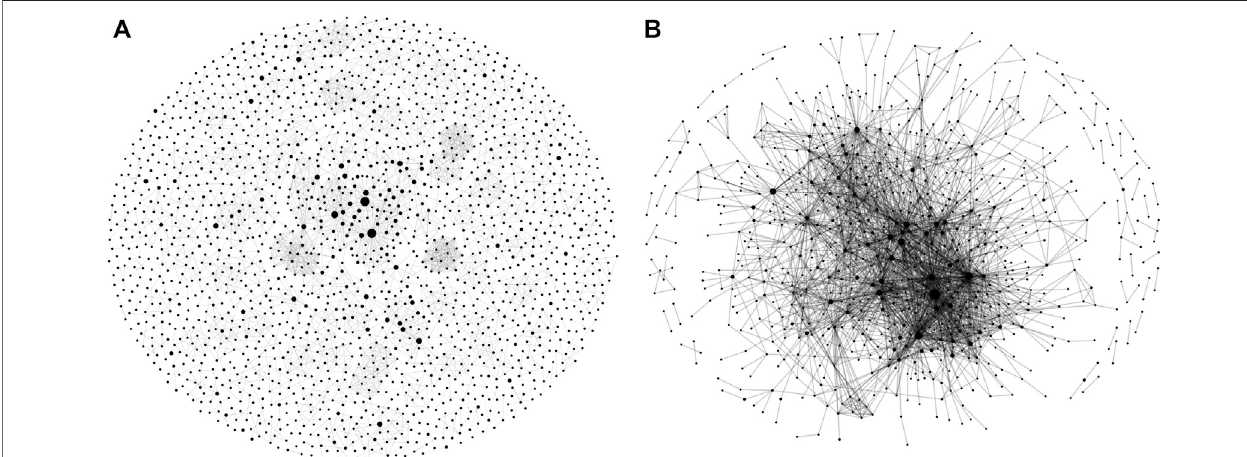
FIGURE 6 | Wide-scale representations of (A) author, and (B) institutional graphs. Each circle, or node, in these and other network graphs visualized in this study, representsanauthor/institution,andlinesbetweencirclesrepresent co-authorship.Thesizeofthecirclecorresponds tothenumberofarticlespublishedbythatauthor/ institutionwithinourdataset.Thethicknessofthelinerepresentsthefrequencyoftheco-authoring.Interactiveversionsoftheseandthefollowinggraphsareavailablevia GitHub